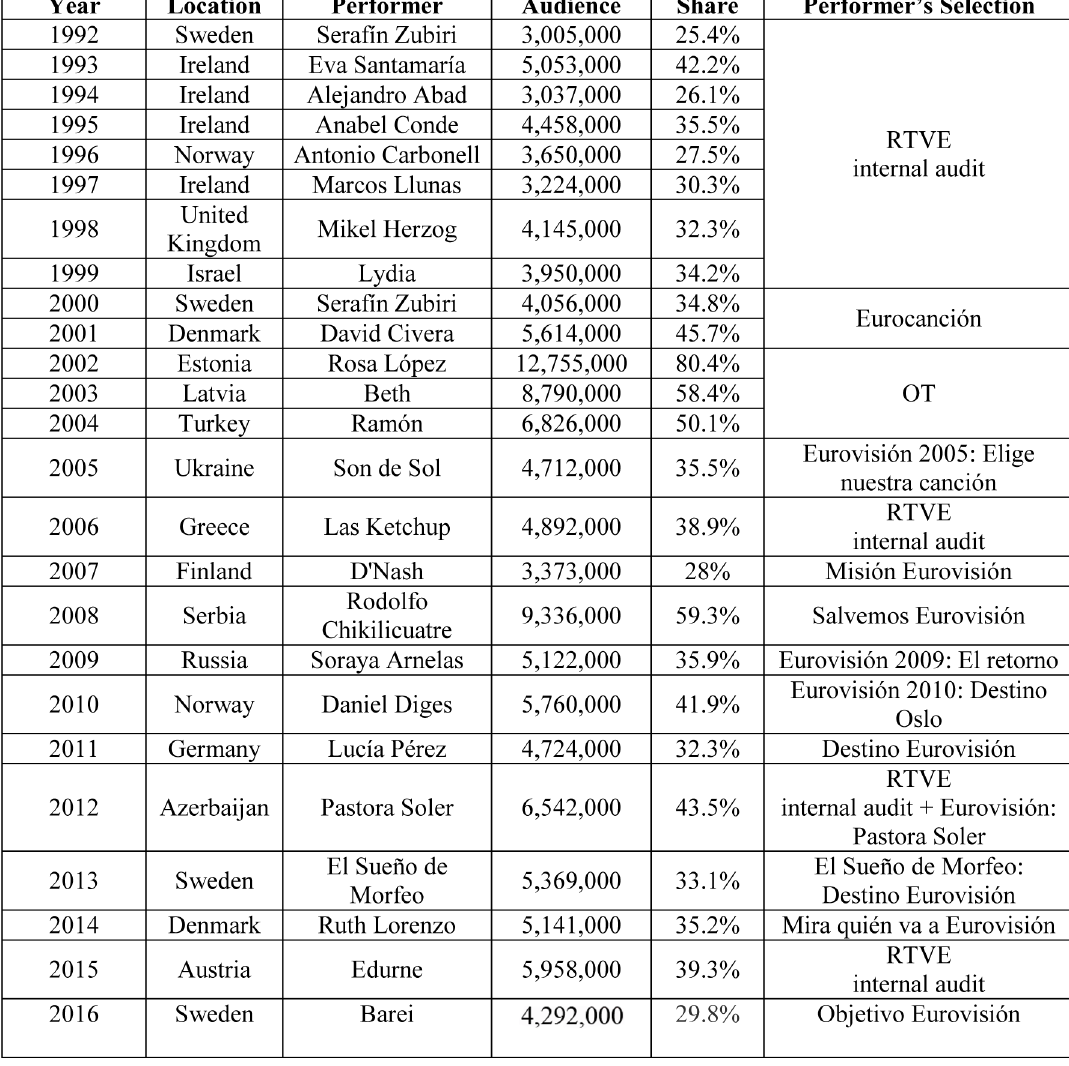
Figure 6. Eurovision Song Contest Spanish Editions (1992 – 2016): Audience, Performers and Selection Method. The data is extracted from different sources, such as: www.historia.foroeurosongcontest.es , www.vertele.com , www.eurovision-spain.com , www. eurovision.tv , www.rtve.es/television/eurovision ,